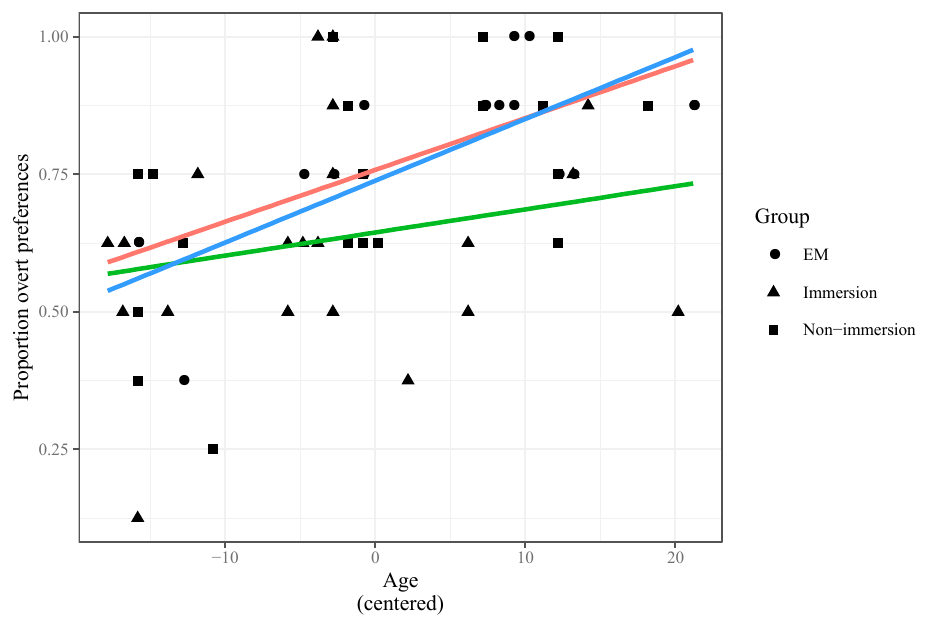
Figure 1. Proportion of overt pronoun responses in English as a function of group.